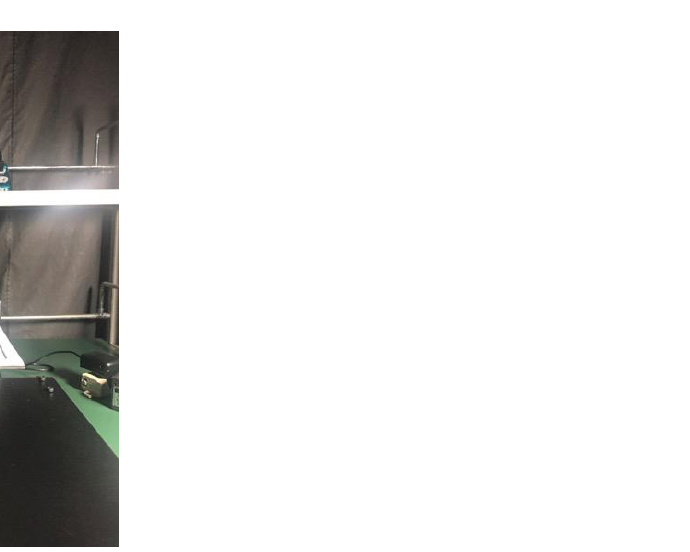
Figure 6. Appearance of the experimental setup. An optical stage is fixed on an optical surface plate, and a glass grid pattern placed on the optical stage is used as the object under measurement. The camera is fixed above the grid pattern. Images are acquired while the grid pattern is precisely displaced by the optical